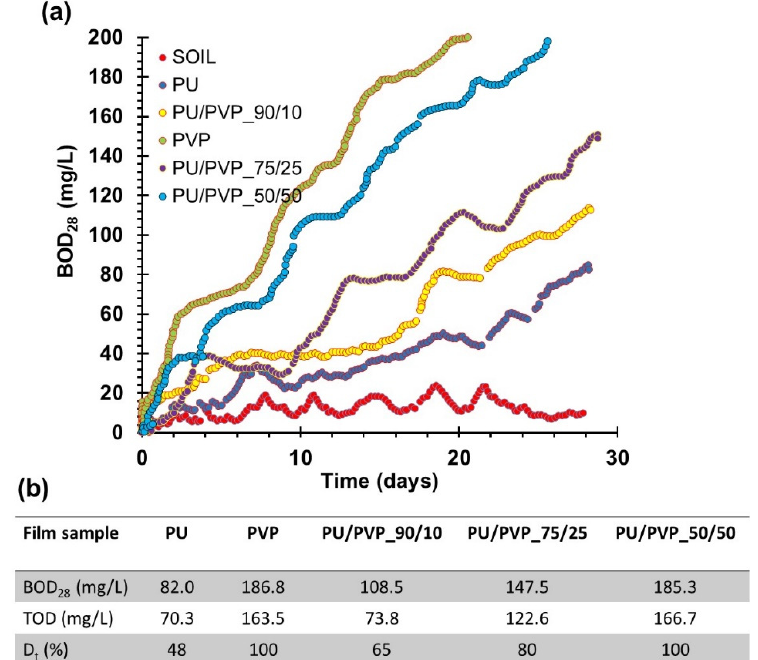
Figure 9. ( a ) Biochemical oxygen demand measurements for pure polymers and the hybrid films, including the control soil sample. ( b ) Estimated theoretical oxygen demand values and biodegradation percent for the films.